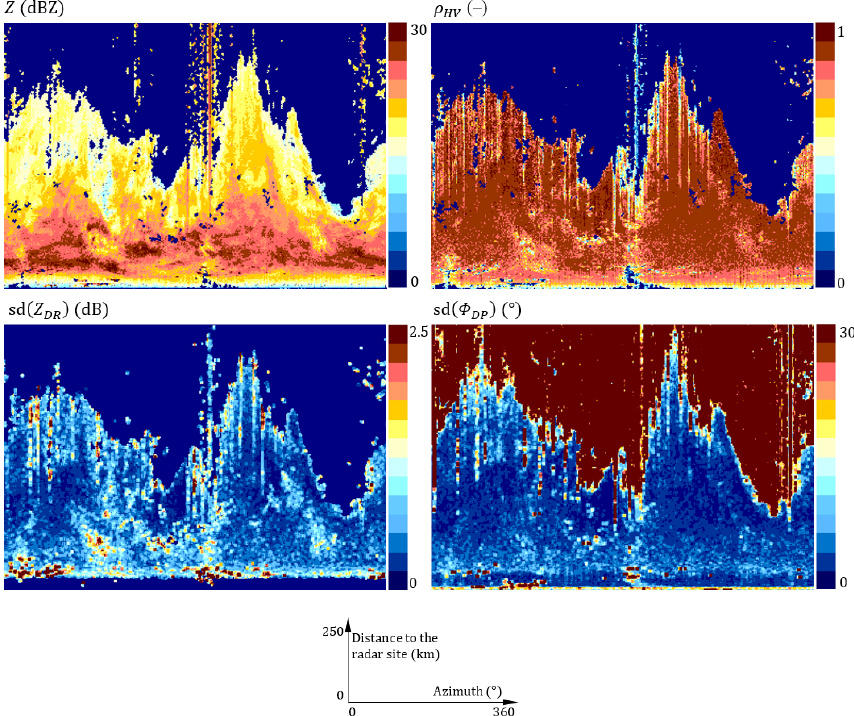
Figure 3. Radar measurement fields from the top left: Z , ρ HV , SD (Z DR ) , and SD ((cid:56) DP ) . Ram ˙ za radar, the lowest elevation, 21 February 2019, 16:40UTC. At the bottom: definition of axes in polar